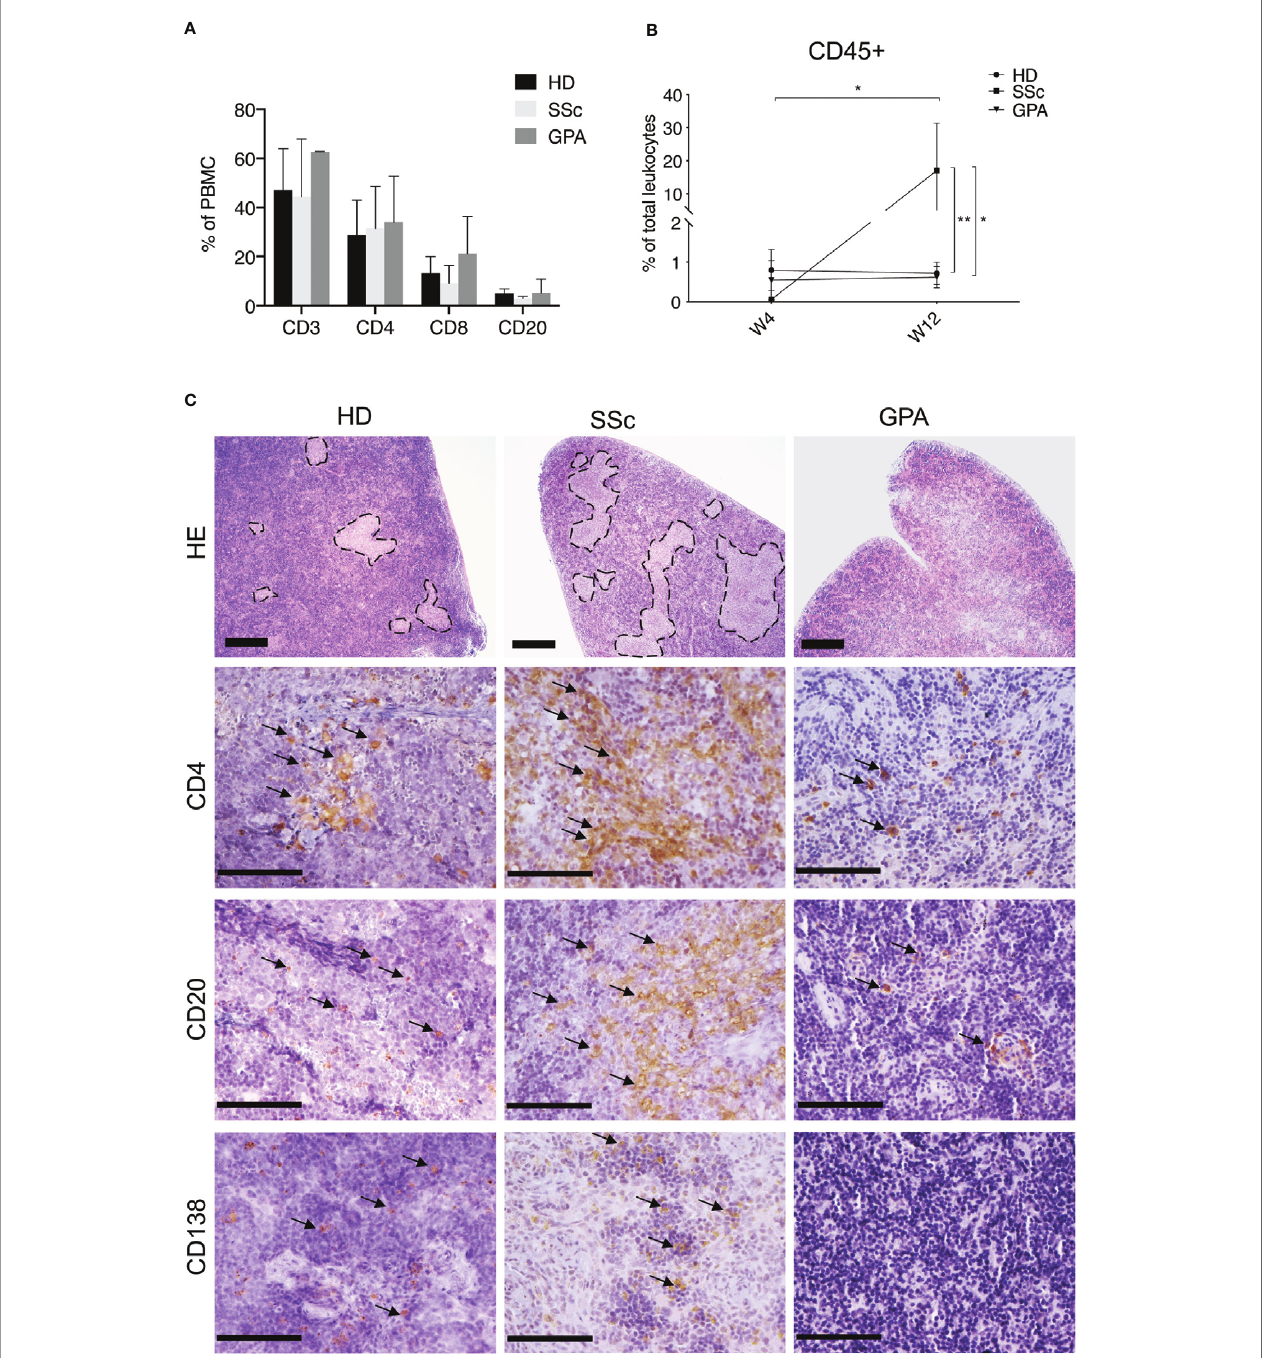
FIGURE 1 | Composition and location of human PBMC in recipient mice. (A) Relative amounts of various lymphocyte subsets in PBMC of patients and healthy donors. The percentages of CD4+, CD8+ and CD20+ cells were detected by FACS after isolation of PBMC from healthy donors (HD, n = 5), SSc patients (n = 4), and patients with GPA (n = 3). (B) Relative amounts of human leukocytes detected in peripheral blood of recipient mice. Human leukocytes were quanti fi ed in murine blood 4 weeks (W4) and 12 weeks (W12) after transfer by CD45 expression using fl ow cytometry. The levels of human leukocytes were de fi ned as number of human leukocytes divided by the respective total leukocyte number in murine blood (HD: n = 8, SSc: n = 5, GPA: n = 5) and expressed as percentages. (C) Representative micrographs of H&E stainings (bar = 500µm) and immunohistochemical stainings of human CD4 + T cells, human CD20 + B cells and human CD138 + cells (bar = 100 µm) in splenic sections of mice receiving PBMC from HD, SSc and GPA patients. The splenic samples were collected 12 weeks after transfer of human PBMC and prepared for histological evaluation. All data are presented as mean ± SD. Statistical analyses were performed using ANOVA (*p < 0.05, **p <